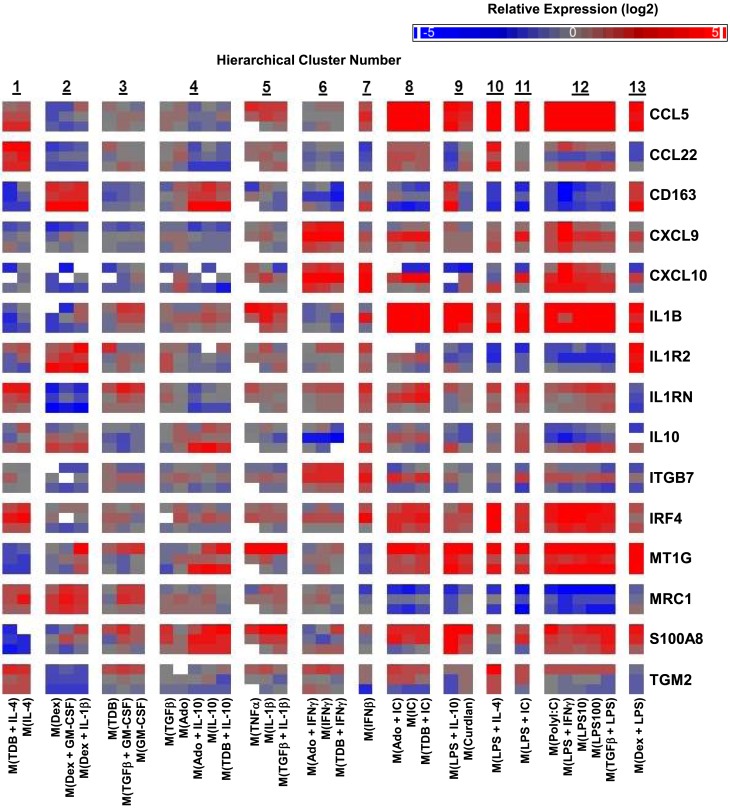
Variability in donor-to-donor MDM gene expression responses was often limited to specific clusters. IFC-based RT-PCR was used to determine the expression of 48 transcripts (45 putative macrophage activation markers and 3 endogenous controls) in MDMs at 24 h post-treatment with 33 distinct activation conditions (columns) (N = 3). Shown here are the results for 15 of the activation marker transcripts. The RNA collected from the first donor (first row for each indicated transcript) had been used in the microarray studies and the RNA from two additional donors (second and third row for each indicated transcript) was collected in independent experiments. Blank areas within clusters represent samples did not meet the Ct cut-off of 25 or, in the case of the third M(TNFα) sample, did not load properly into the IFC device.